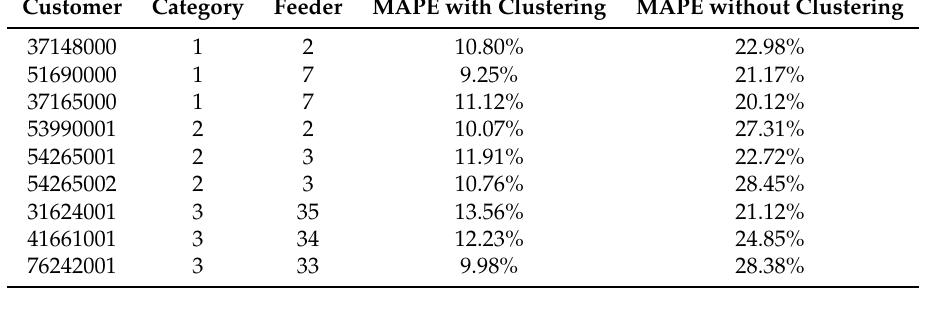
Table 7. Compared MAPEs for nine customers in three categories with or without clustering.